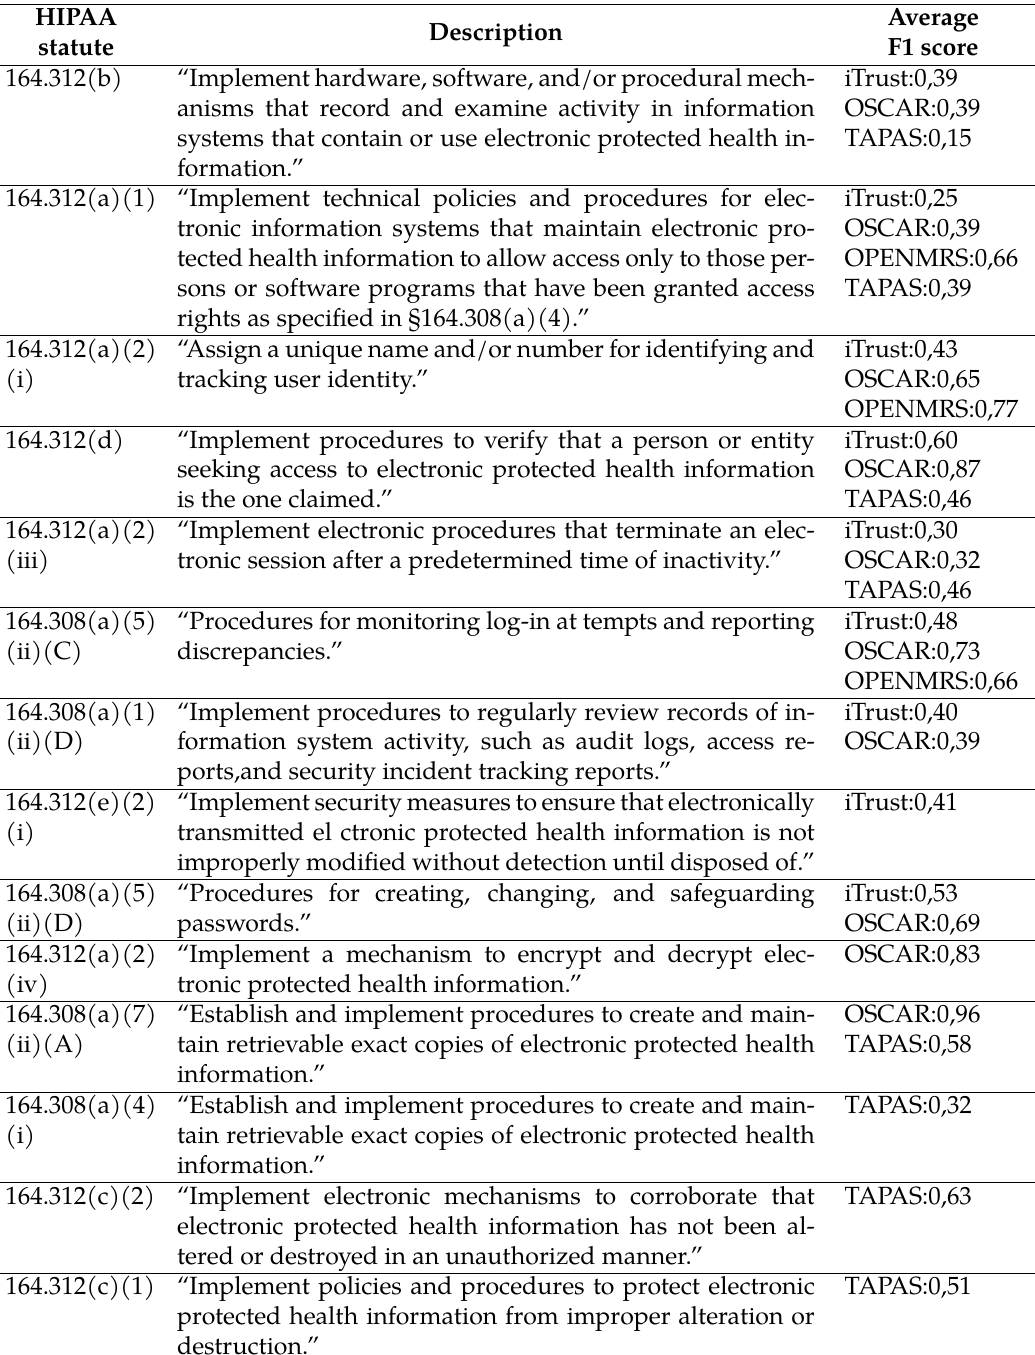
Table 9: Summary of results for all healthcare systems analyzed in this